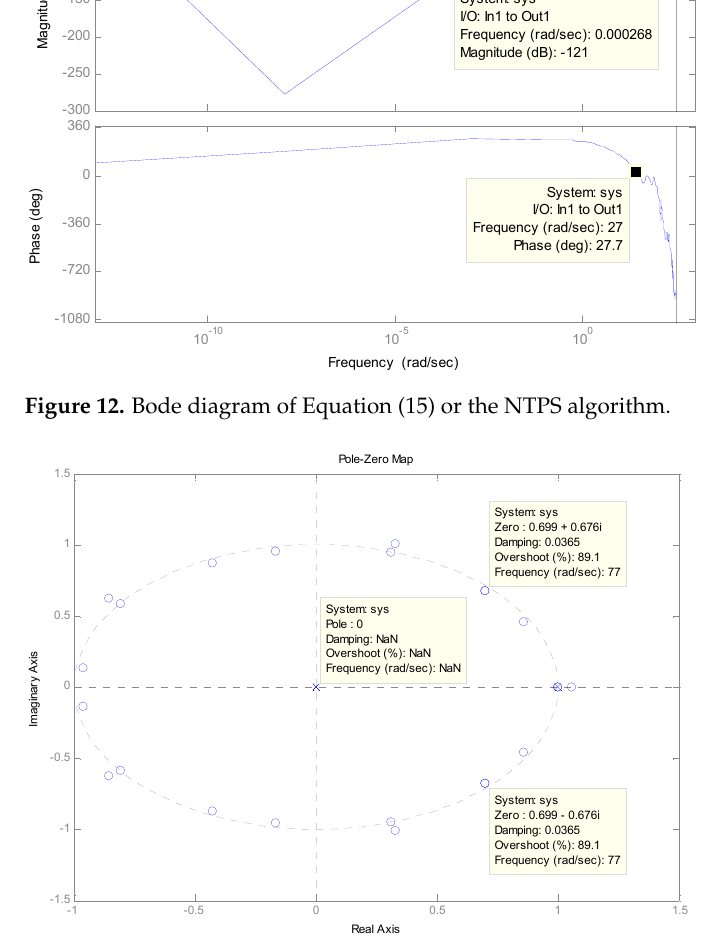
Figure 13. Pole-zero map of the Equation (15) or the NTPS algorithm.